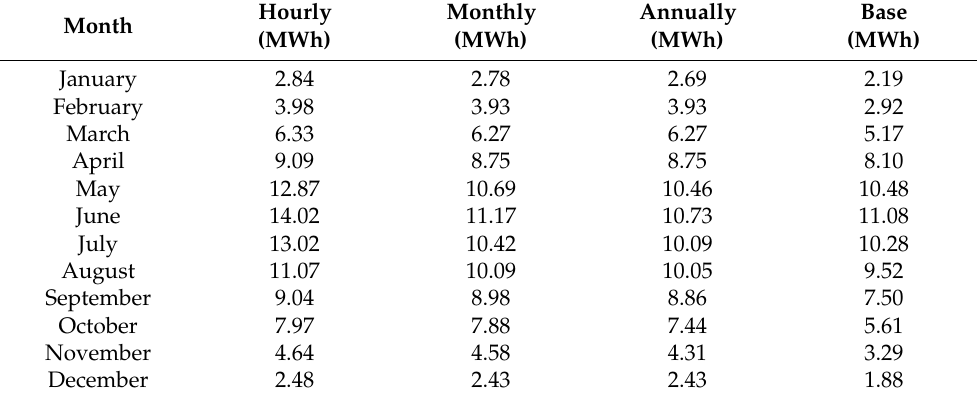
Table 2. Simulation